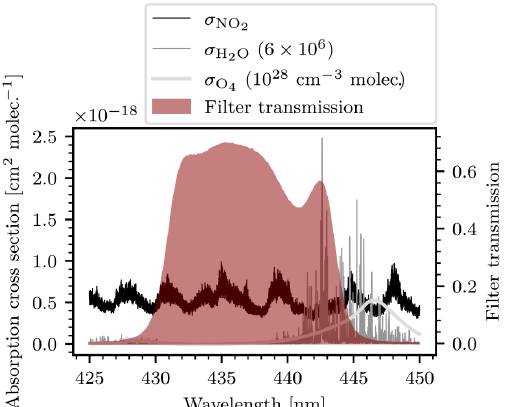
Figure 7. Cross sections of NO 2 , H 2 O, and O 4 , as well as the trans- mission of the bandpass filter (red shaded area) used. The cross sec- tions of H 2 O and O 4 were scaled (see legend) in order to display them on a mutual axis.